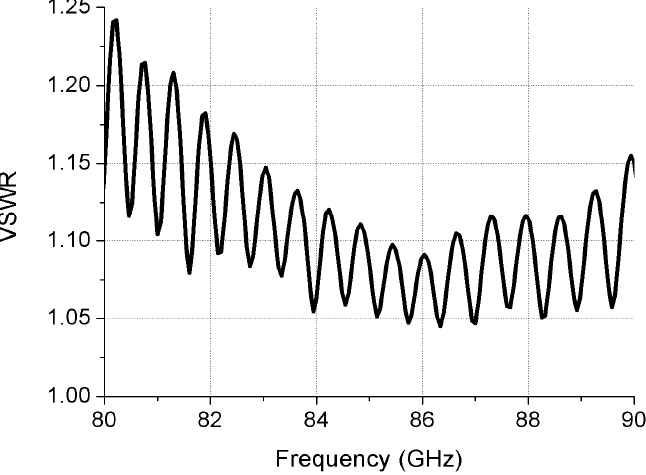
Figure 13. Matching characteristics of the T-shaped coupler.